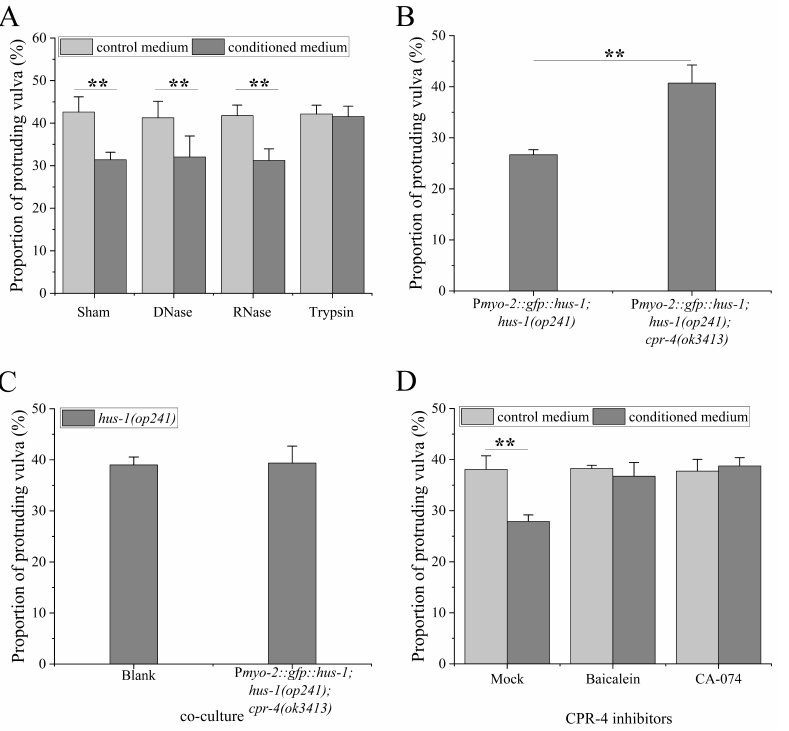
Figure 5. Role of CPR-4 in inter-tissue regulation of the pharyngeal ATR cascade: ( A ) the vulval radiosensitivity of hus-1 worms cultured in conditioned medium treated with DNase, RNase, and trypsin; ( B ) the vulval radiosensitivity of worm line BPL1131: P myo-2::gfp::hus-1; hus-1(op241); cpr- 4(ok3413) ; ( C ) the vulval radiosensitivity of hus-1 worms co-cultured with BPL1131 worms, Blank: culture alone; ( D ) the vulval radiosensitivity of hus-1 worms cultured in the conditioned medium treated with CPR-4 inhibitors baicalein or CA-074. Results are means ± SD ( n ≥ 3, t -test, ** p <